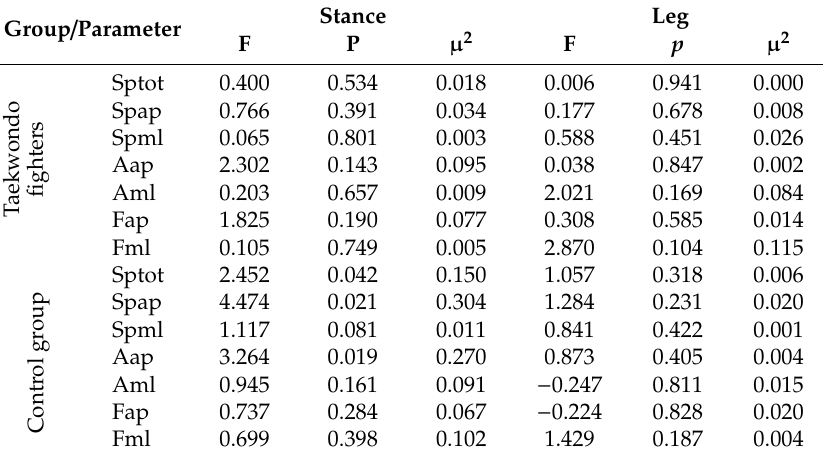
Table 1. Di ff erences between balance